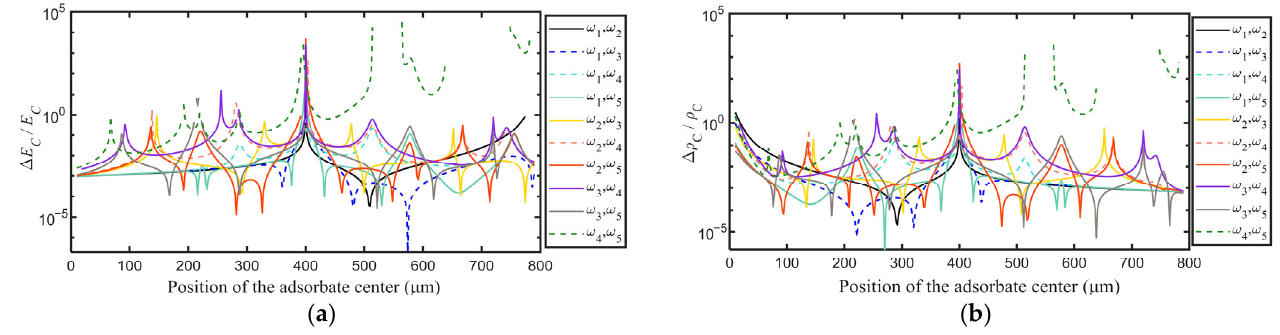
Figure 5. The relative physical parameter errors of the platinum adsorbate when 0.01% frequency error were added to the first five order natural frequencies. ( a ) Young’s modulus errors, ( b ) Density errors.